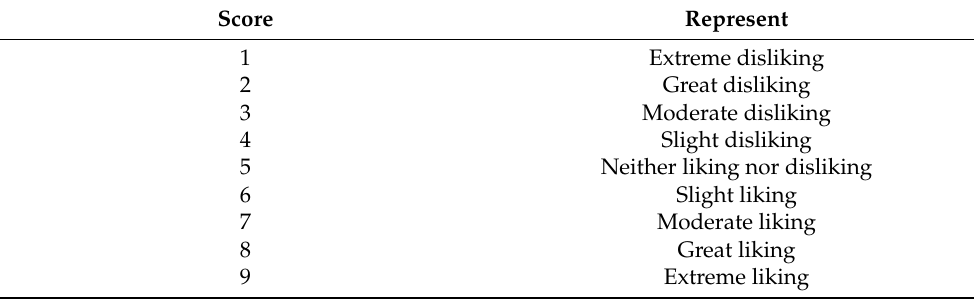
Table 2. Scoring criteria for sensory evaluation. Score